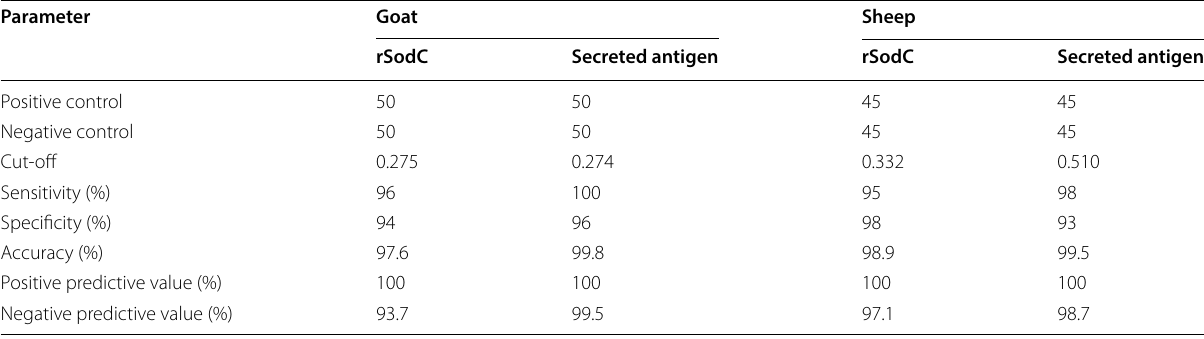
Table 3 Validation parameters for indirect ELISA using positive and negative control serum samples from goats and sheep. rSodC protein and secreted C. pseudotuberculosis antigens were used as test antigens